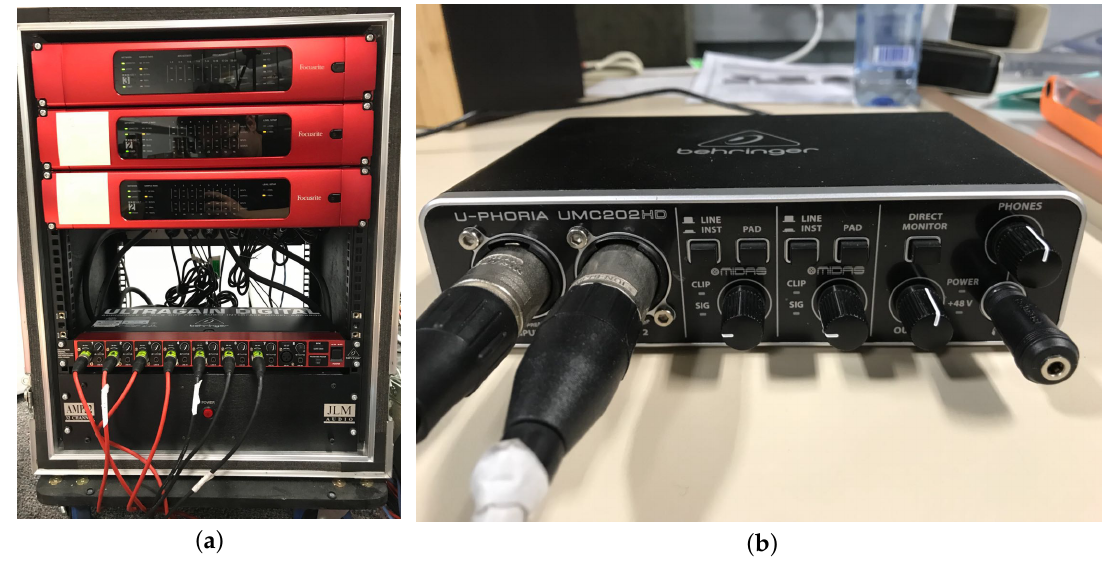
Figure 12. System hardware. ( a ) Dante audio network system; ( b ) U-PHORIA UMC202HD audio